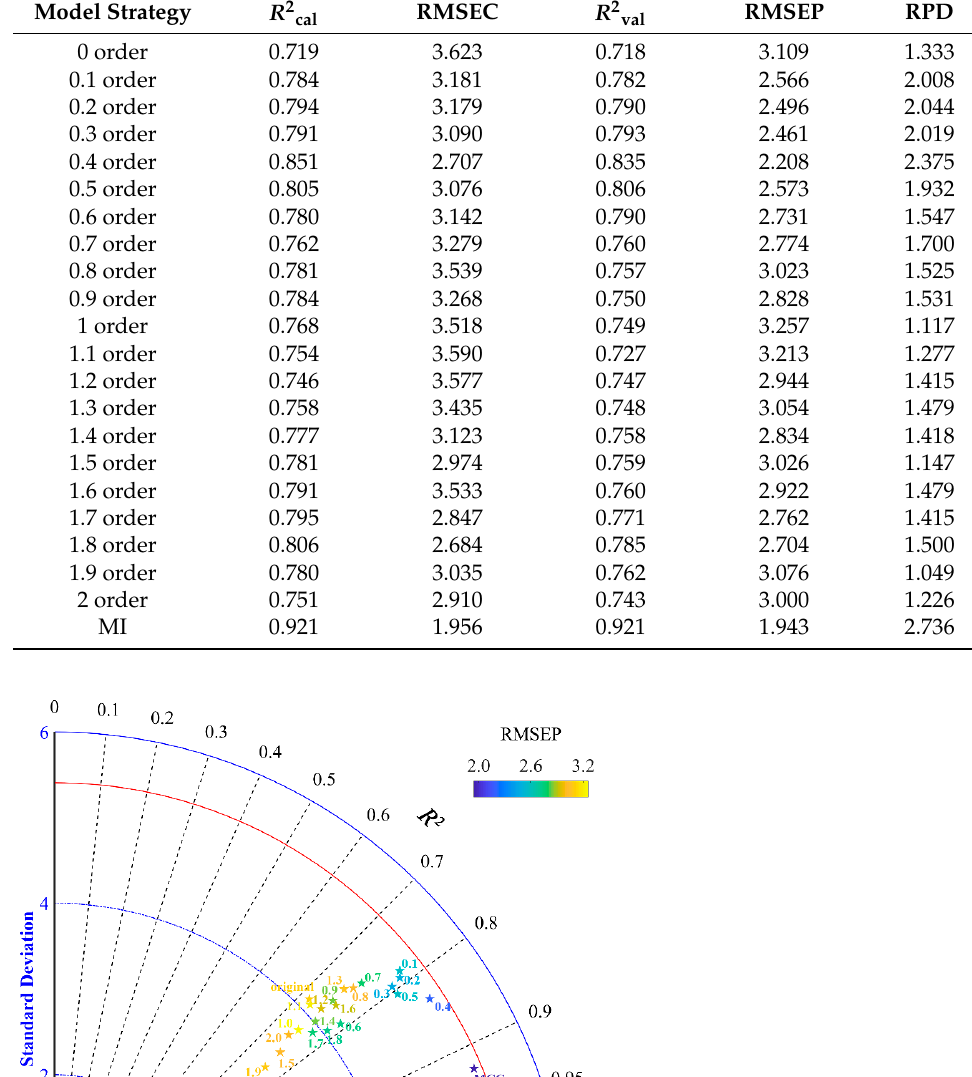
Table 6. Comparisons of the XGBoost models for SMC retrieval based on different order model- ing strategies.